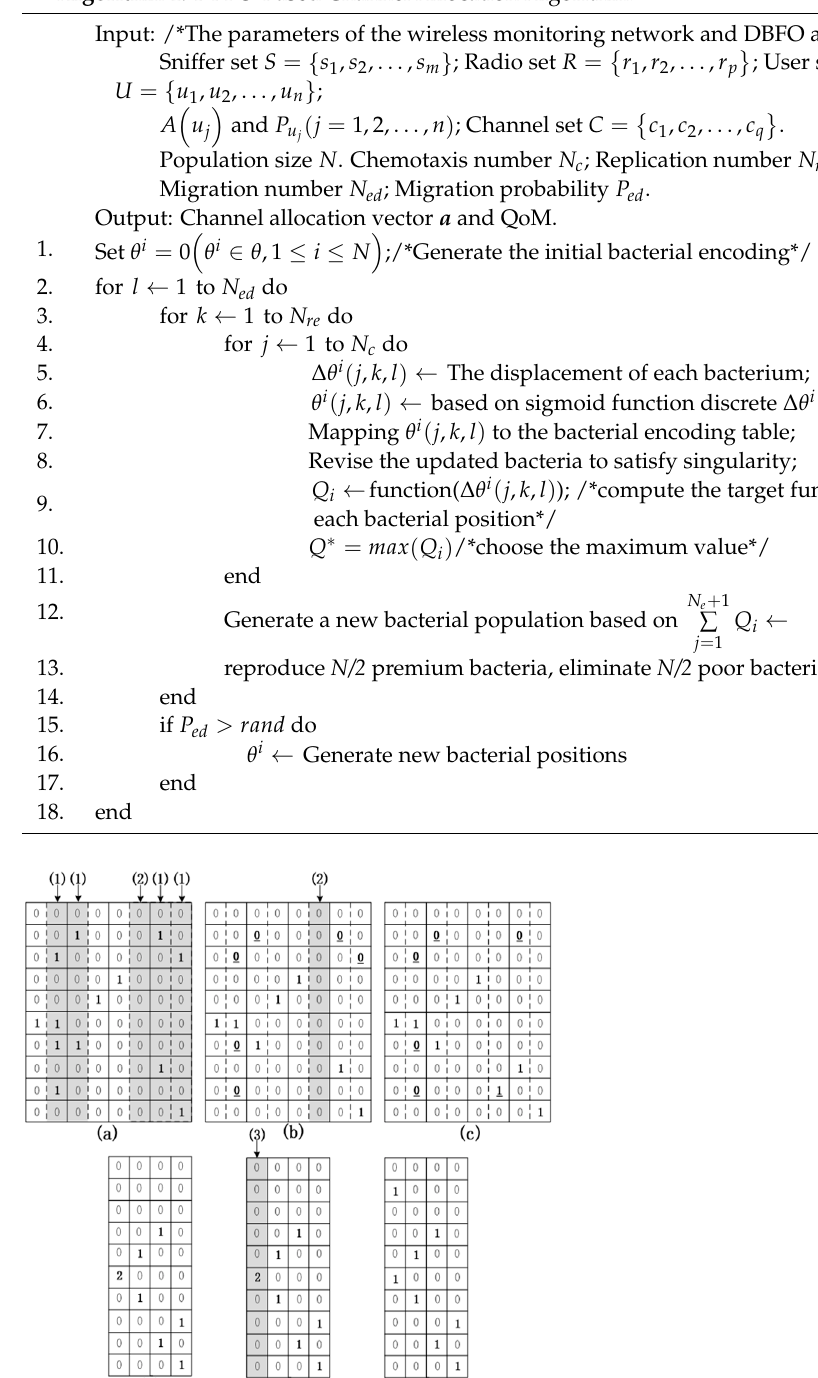
Algorithm 1. DBFO-Based Channel Allocation Algorithm.